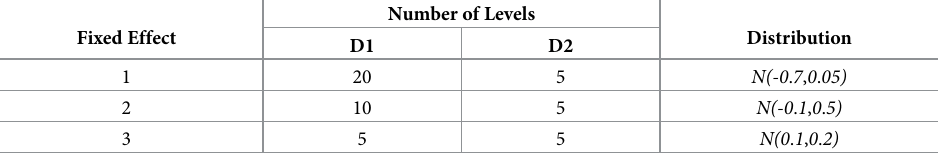
Table 1. Number of classes and distributions used to simulate the systematic effects for the large (D1) and small (D2)